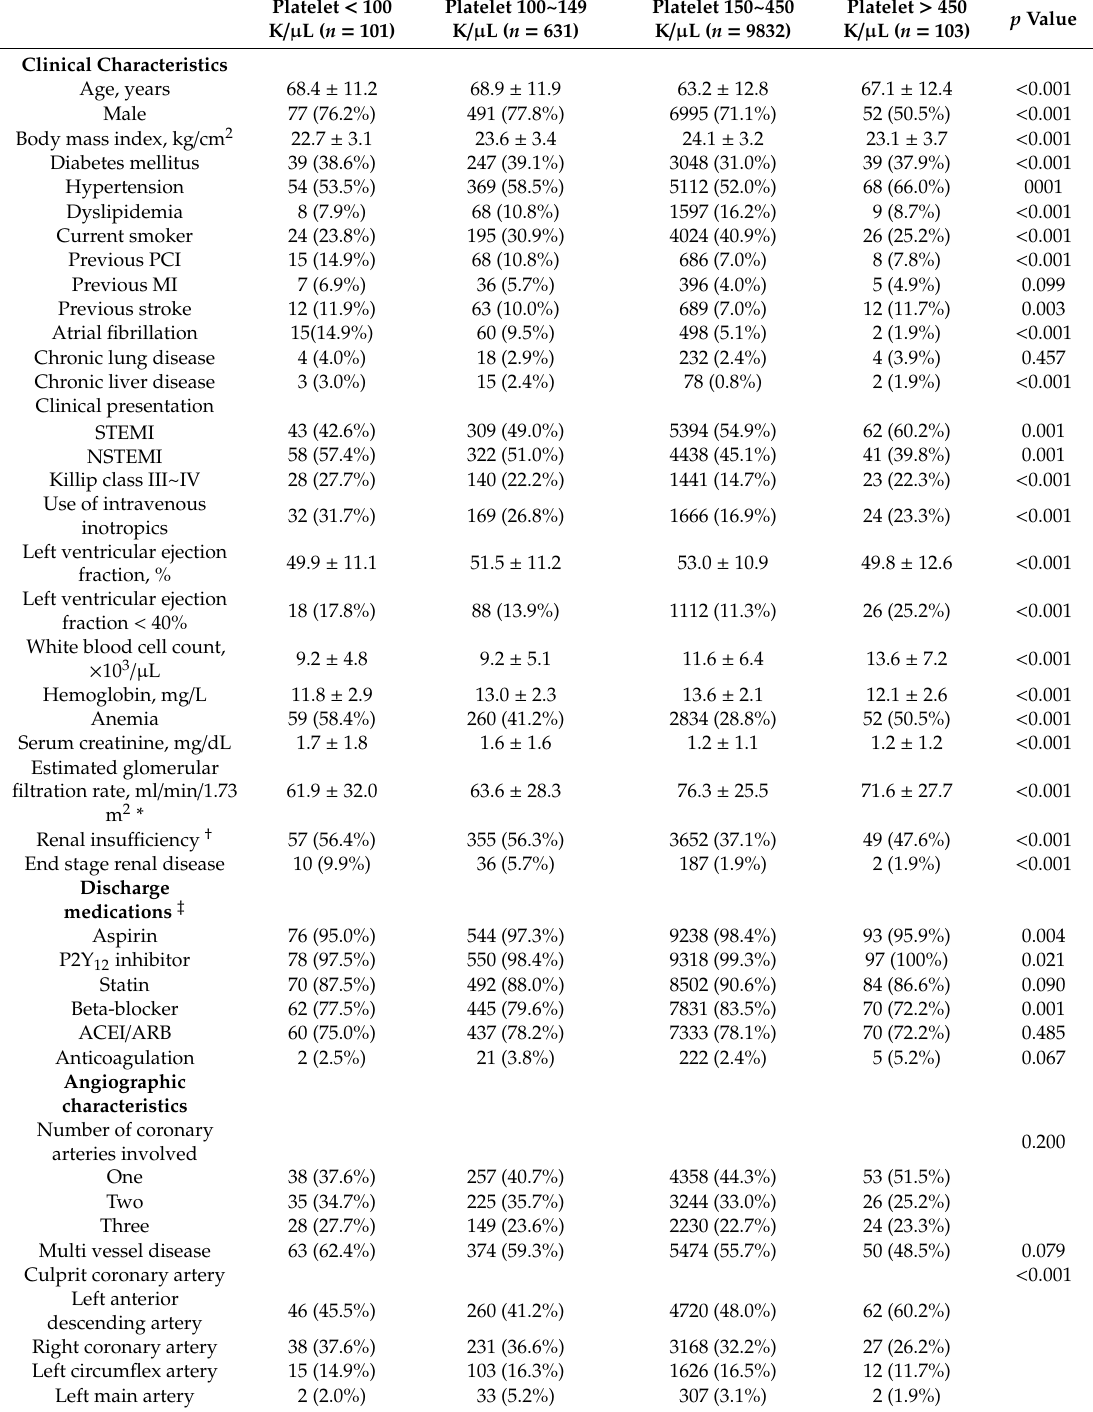
Table 1. Baseline clinical characteristics, discharge medications, angiographic and procedural characteristics according to baseline platelet